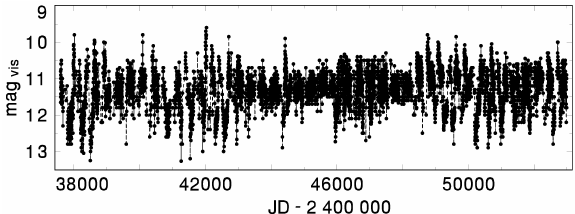
Figure 2: Long-term activity of the supersoft X- ray source V Sge in the optical band (AAVSO and AFOEV data). Notice the large variations of activ- ity on the timescale of several years (from the segments with only small fluctuations to the segments with the large-amplitude transitions between the high and low states). Adapted from ˇSimon & Mattei (1999). Dividing the series of the optical (CCD and pho- toelectric) observations of V Sge, obtained at different